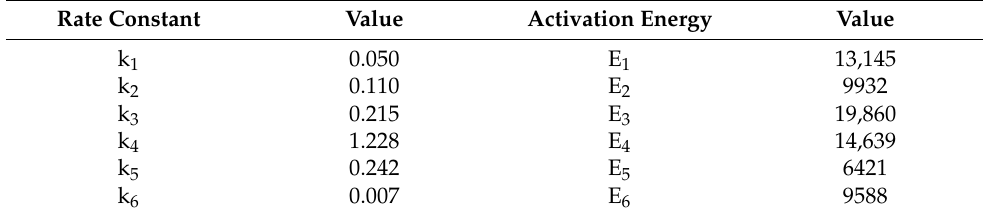
Table 2. Rate constant and activation energy values